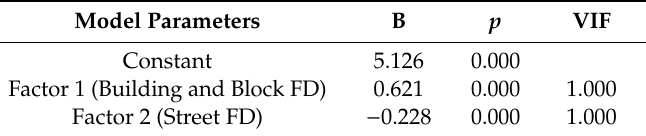
Table 4. Model coe ffi cients and collinearity